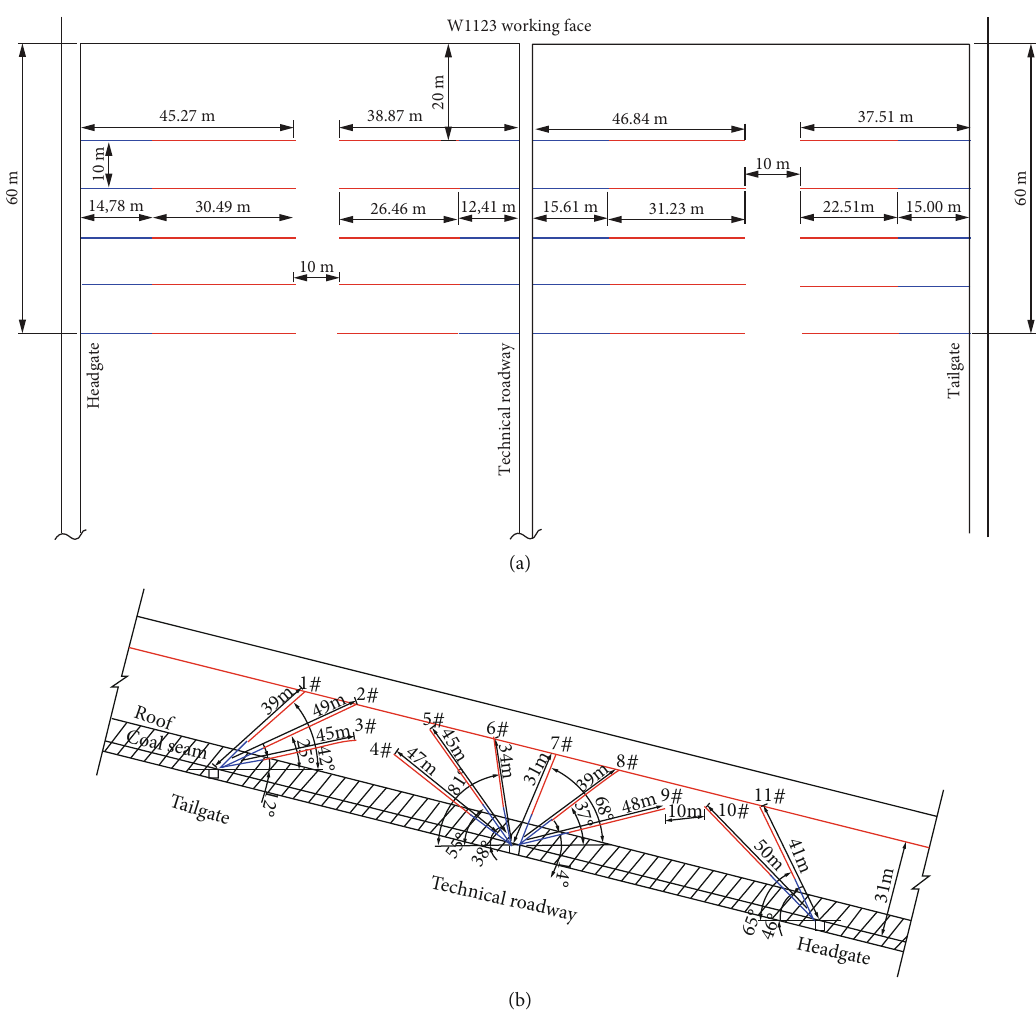
Figure 16: Roof precracking blasthole layout scheme. (a) Plane diagram. (b) Section diagram. Table 4: Parameters of roof precracking blasthole drilling and fi lling